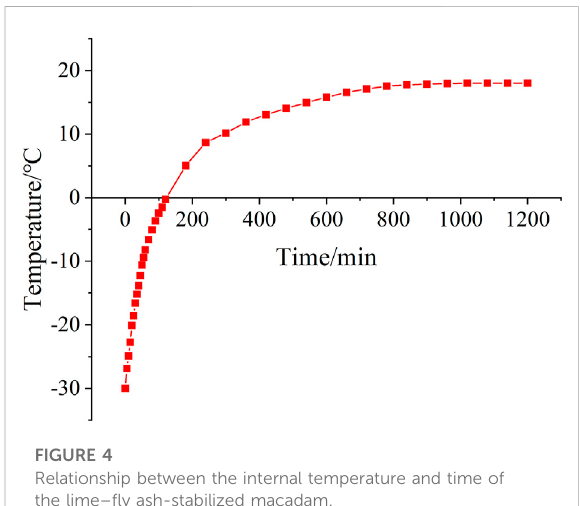
FIGURE 4 Relationship between the internal temperature and time of the lime – fl y ash-stabilized macadam.